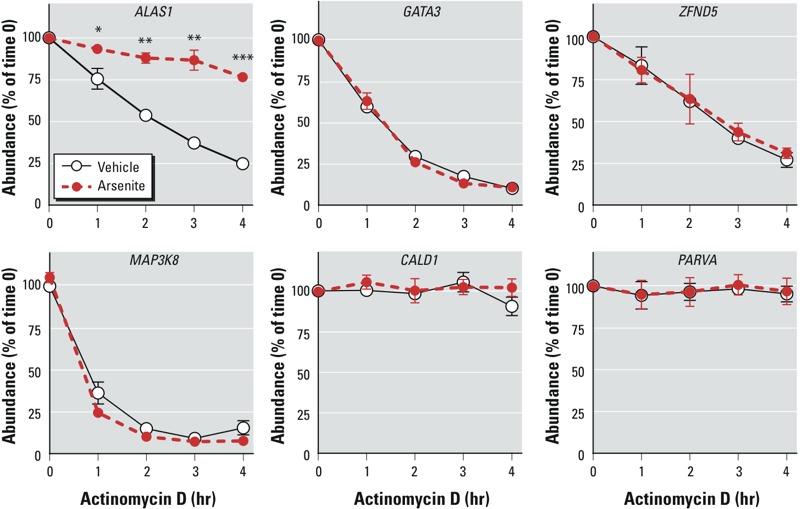
Effect of arsenite on the stability of ALAS1, GATA3, ZFND5, MAP3K8, CALD1, and PARVA mRNA in cells treated with vehicle or arsenite for 24 hr and then treated with actinomycin D for 1–4 hr, as determined by real-time RT-PCR. The apparent arsenite-induced stabilization of ALAS1 mRNA seen in the microarray analyses was confirmed; however, the differences in decay rates suggested by microarray for GATA3 and MAP3KB mRNAs shown in Figure 2 were not confirmed. Arsenite showed no effect on the decay rates of several other transcripts, including one with an intermediate half-life (ZFAND5) and two relatively stable transcripts (CALD1 and PARVA) during the 4-hr time course. Relative transcript abundance was calculated as a fraction of transcript abundance at time 0, before the addition of actinomycin D (set at 100%). Data are expressed as mean ± SE of four independent experiments.
*p < 0.05. **p < 0.01. ***p < 0.001.